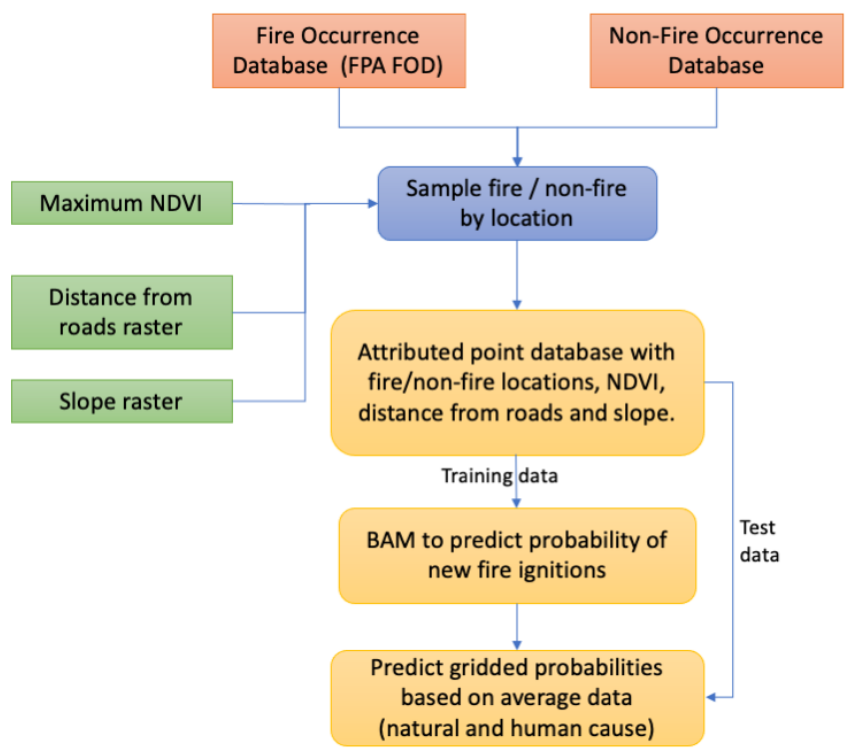
Figure 3. General workflow for model building and evaluation including inputs, sampling of wildfire presence and absence locations, extraction of explanatory variables, creation of an attributed point wildfire database, model fitting of new wildfire occurrences, and the final spatial predictions of wildfire ignition